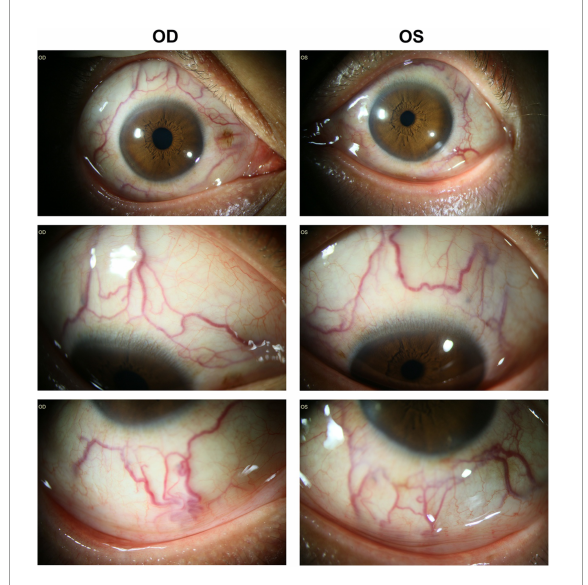
FIGURE1 Prominent dilated episcleral and conjunctival vessels were noted in both eyes without signs of rubeosis of iris or iridocorneal angle closure. OD, right eye; OS, left eye.